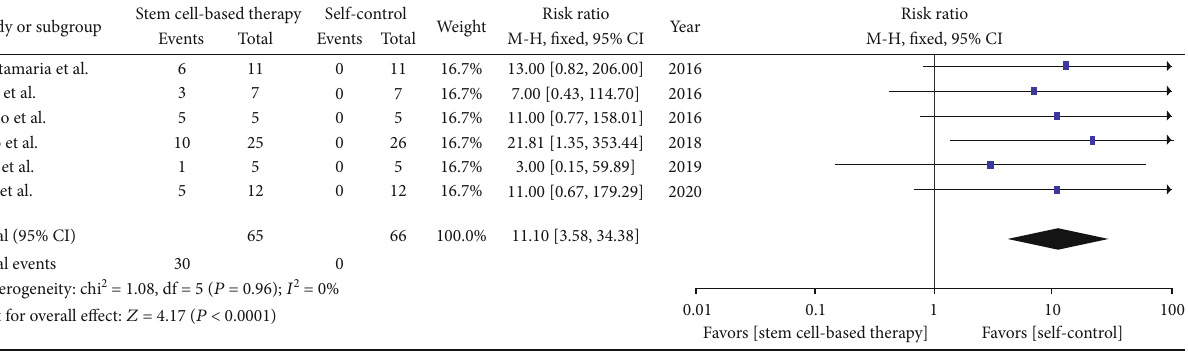
Figure 3: Pregnancy outcome.